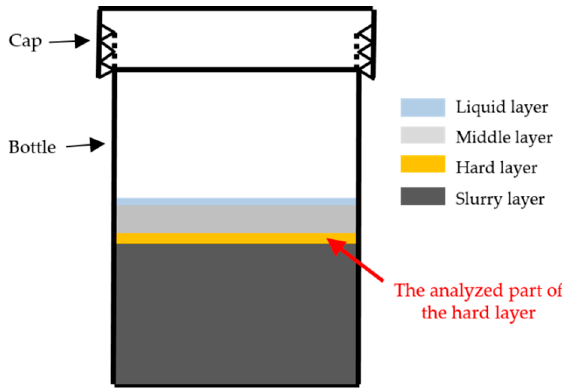
Figure 6. Schematic diagram of the layered system.